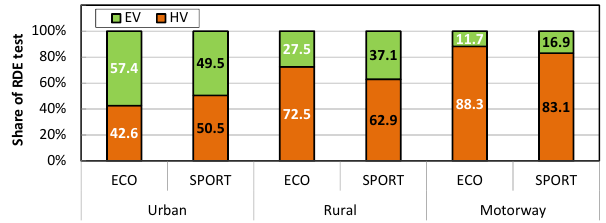
Fig. 19. The share of hybrid and electric mode in urban, rural and highway conditions in relation to the distance of the vehicle test